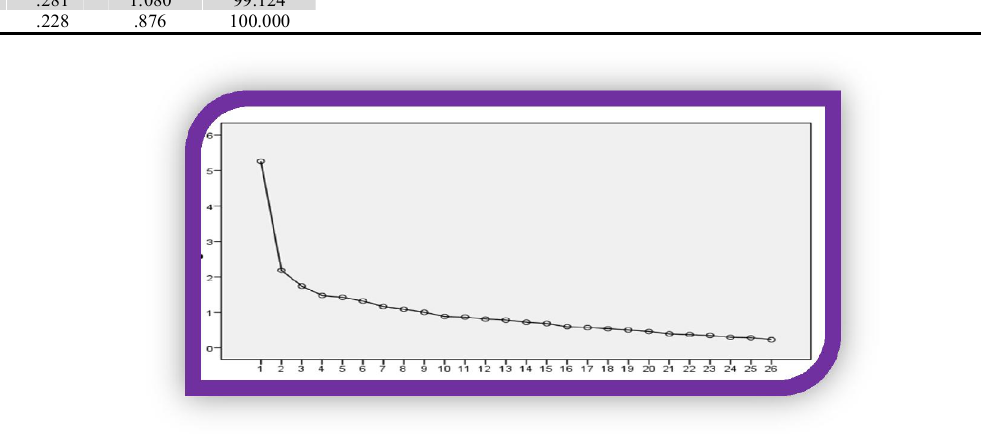
Fig. 1. The summary of Scree plot